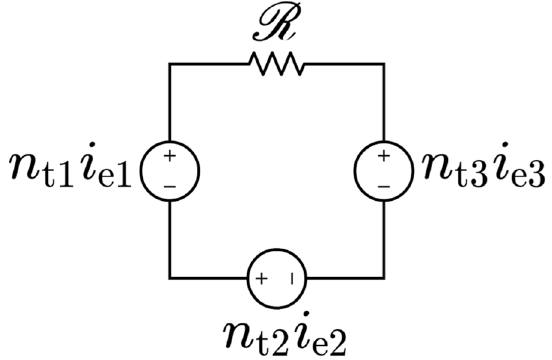
Fig. 13 Equivalent circuit model of the magnetic structure shown in Fig.